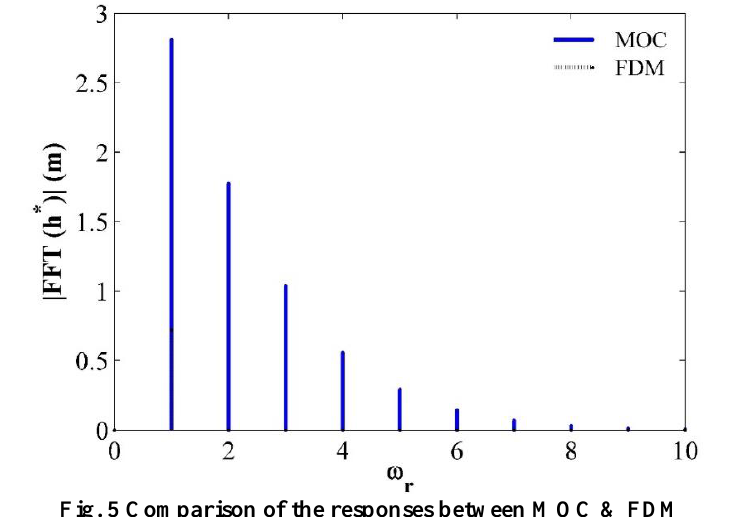
Fig. 5 Comparison of the responses between MOC &